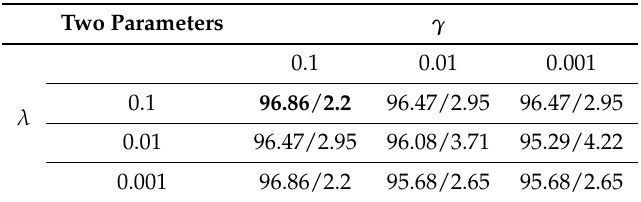
Table 3. Average recognition rates and standard deviations of K-LRCS with different parameter settings on the Traffic dataset (%).